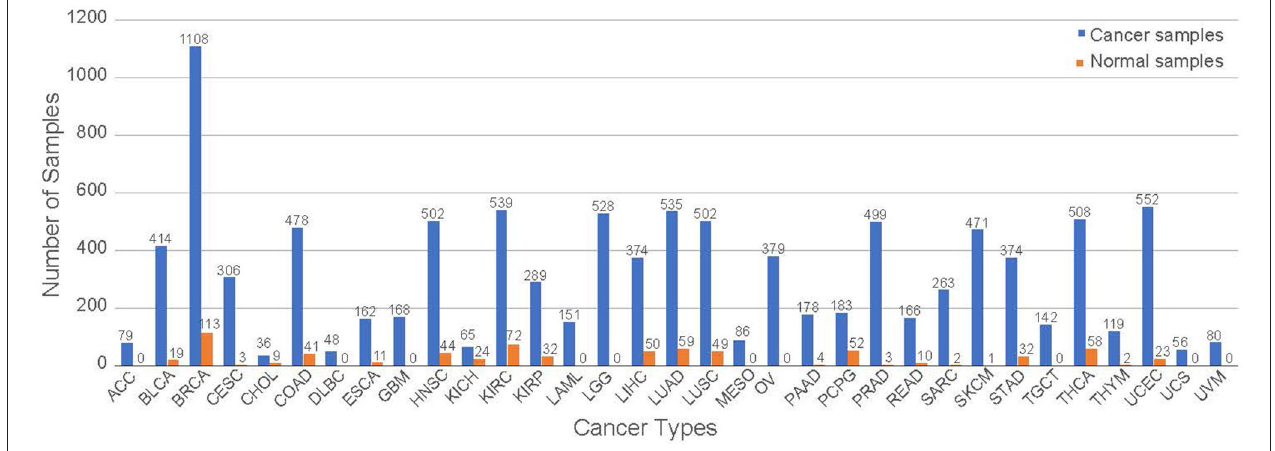
FIGURE 1 | The distribution of the samples for each tumor group. The samples are separated from cancerous and normal tissue samples.